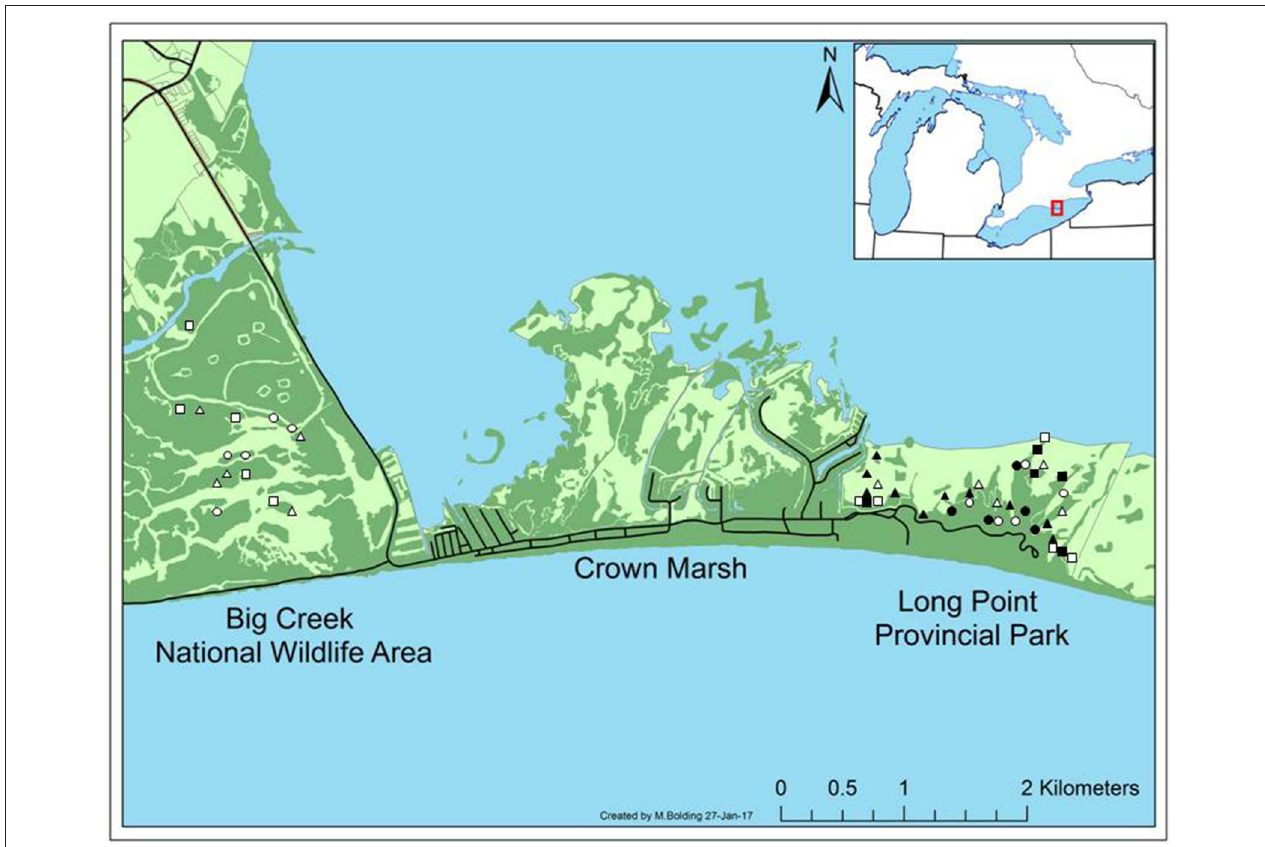
FIGURE 1 | Study location in the Big Creek National Wildlife Area (42 ◦ 35 ′ N, 80 ◦ 27 ′ W) and Long Point Provincial Park (42 ◦ 34 ′ N, 80 ◦ 22 ′ W) management units of the Long Point peninsula. Circles are meadow marsh sites, squares are cattail marsh sites, and triangles are P. australis -invaded sites. Black symbols were sampled in 2017, white symbols were sampled in